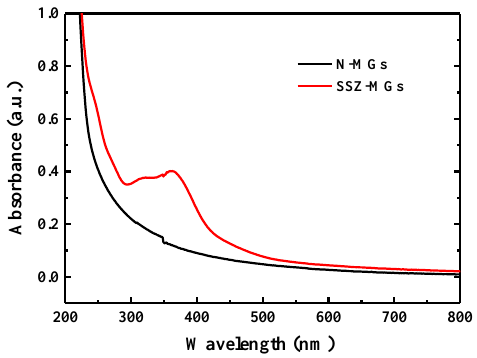
Figure 2. UV-vis spectra of N-MGs and SSZ-MGs aqueous suspensions with concentration of 0.099 mg/mL at 25 °C and pH of 5.6.